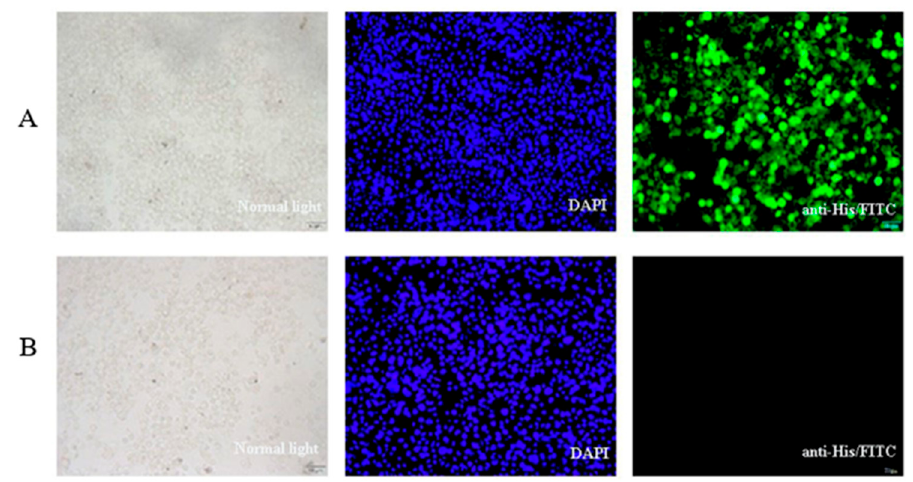
Figure 4. Immunofluorescence assay of recombinant protein expression in BmE cells infected with the recombinant virus: ( A ) BmE cells infected with rBmBac-VP35-VP4; and ( B ) BmE cells infected with rBmBac-wild. From left to right: the BmE cells under normal light, UV light and treated with mouse anti-His-tag and Daylight 488-conjugated goat anti-mouse IgG.